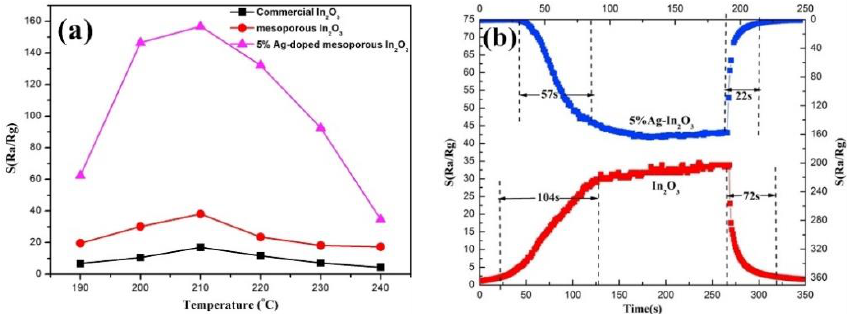
Figure 18. Gas response sensitivities versus operating temperature toward 50 ppm HCHO ( a ); the response and recovery time ( b ) of mesoporous In 2 O 3 and 5% Ag-loaded mesoporous In 2 O 3